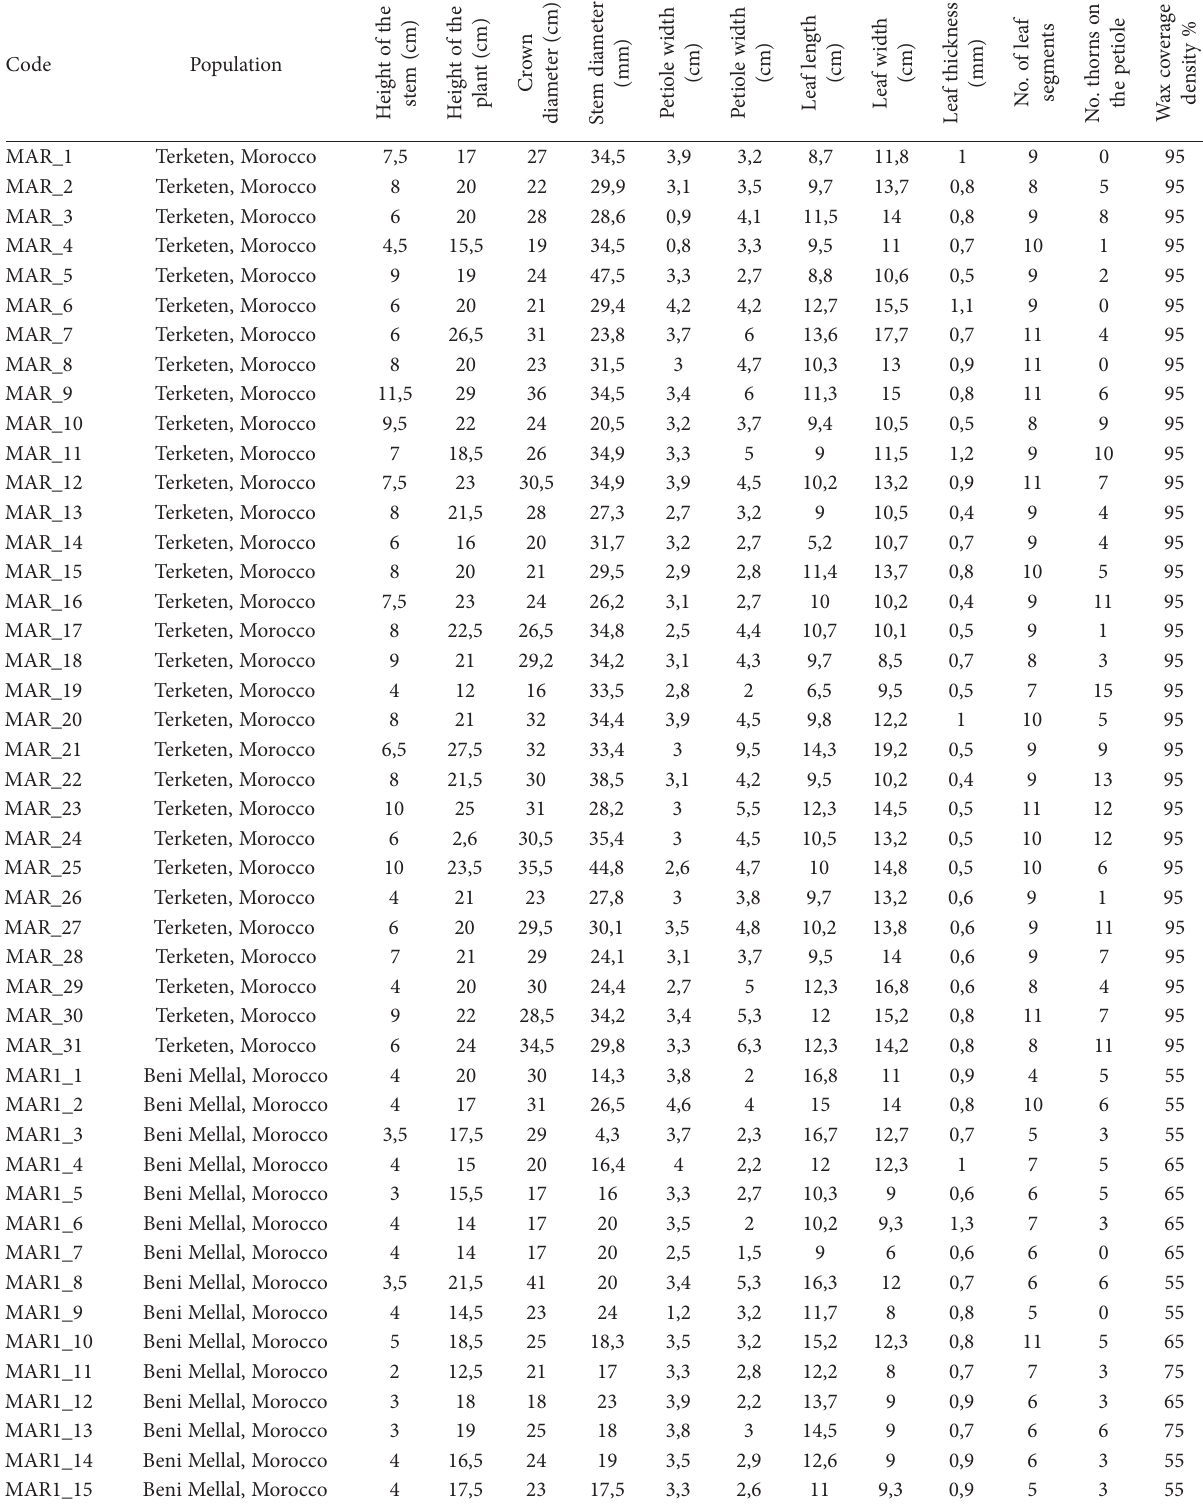
Supplemental Data file 1. Mean of the measures on morphological characters used for statistical